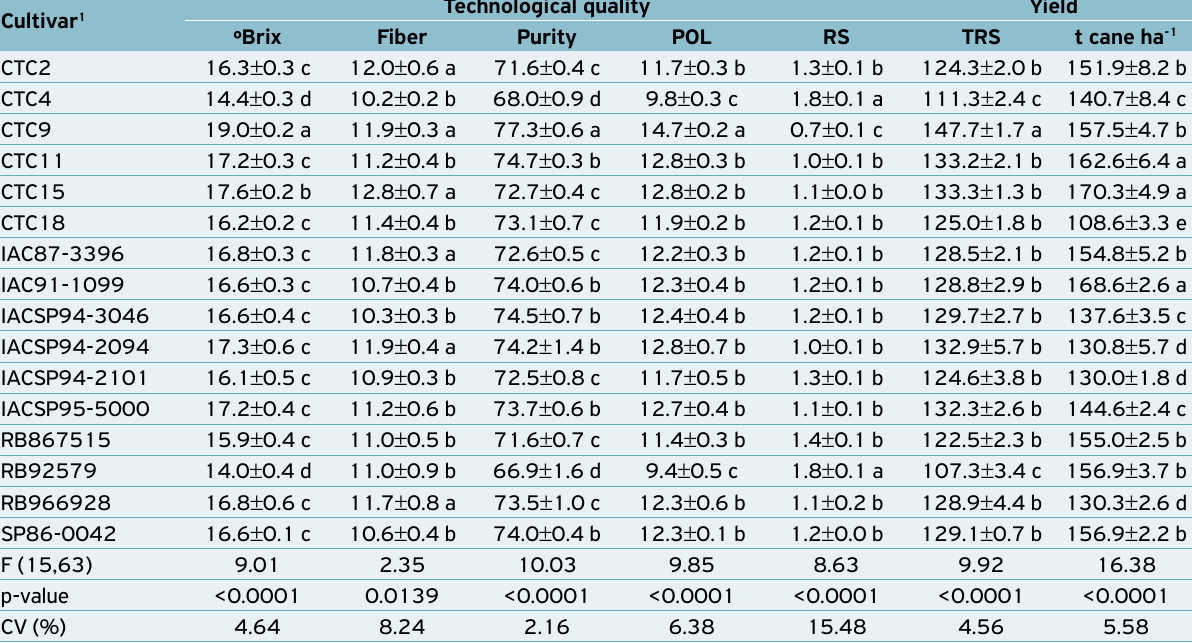
Table 3. Parameters of technological quality and yield of 16 sugarcane cultivars: experiment 1. Goianésia, GO, Brazil, 2012. Technological quality Yield Cultivar 1 ºBrix Fiber Purity POL RS